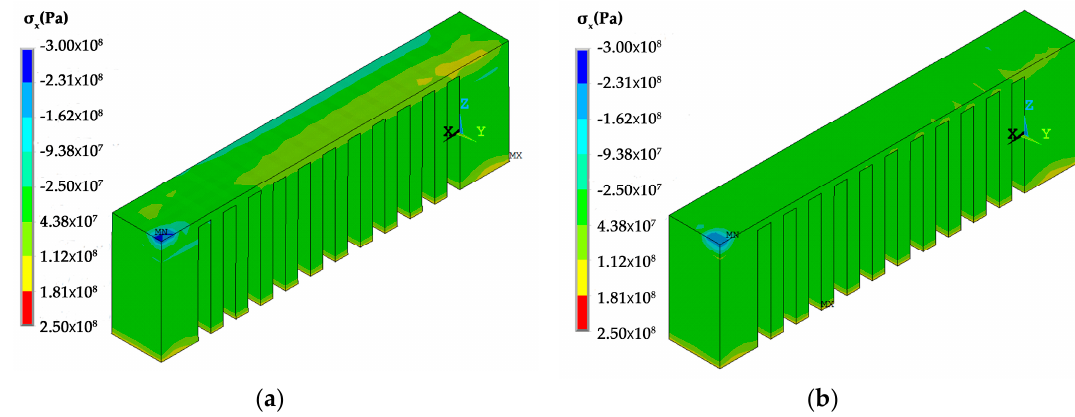
( b ) Figure 10. Residual stress σ x distribution of the specimens under different scanning strategies as they are cooled to room temperature: ( a ) the x scanning route; and, ( b ) the y scanning route. Figure 11. Residual stress σ x distribution of the specimens under different scanning strategies as cooled to room temperature along the X path. 02040 6080100120140160 0